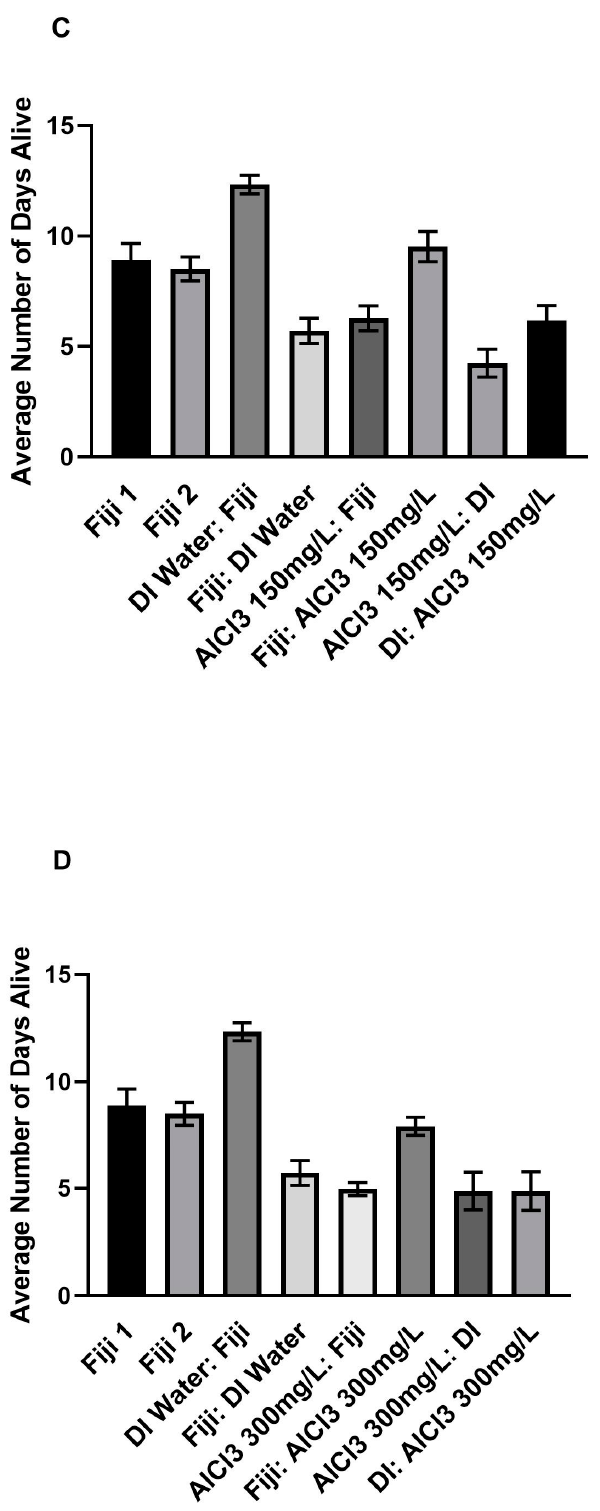
Figure 4. Average number of days alive by aluminum concentration with standard error of the means (SEM). The different colors represent the different groups. ( A ) Average number of days alive for AlCl3 25 mg/L and respective control group bees. ( B ) Average number of days alive for AlCl3 75 mg/L and respective control group bees. ( C ) Average number of days alive for AlCl3 150 mg/L and respective control group bees. ( D ) Average number of days alive for AlCl3 300 mg/L and respective control group